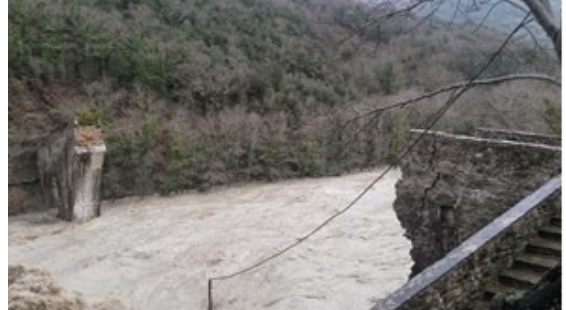
Figure 10: The remains of the bridge after